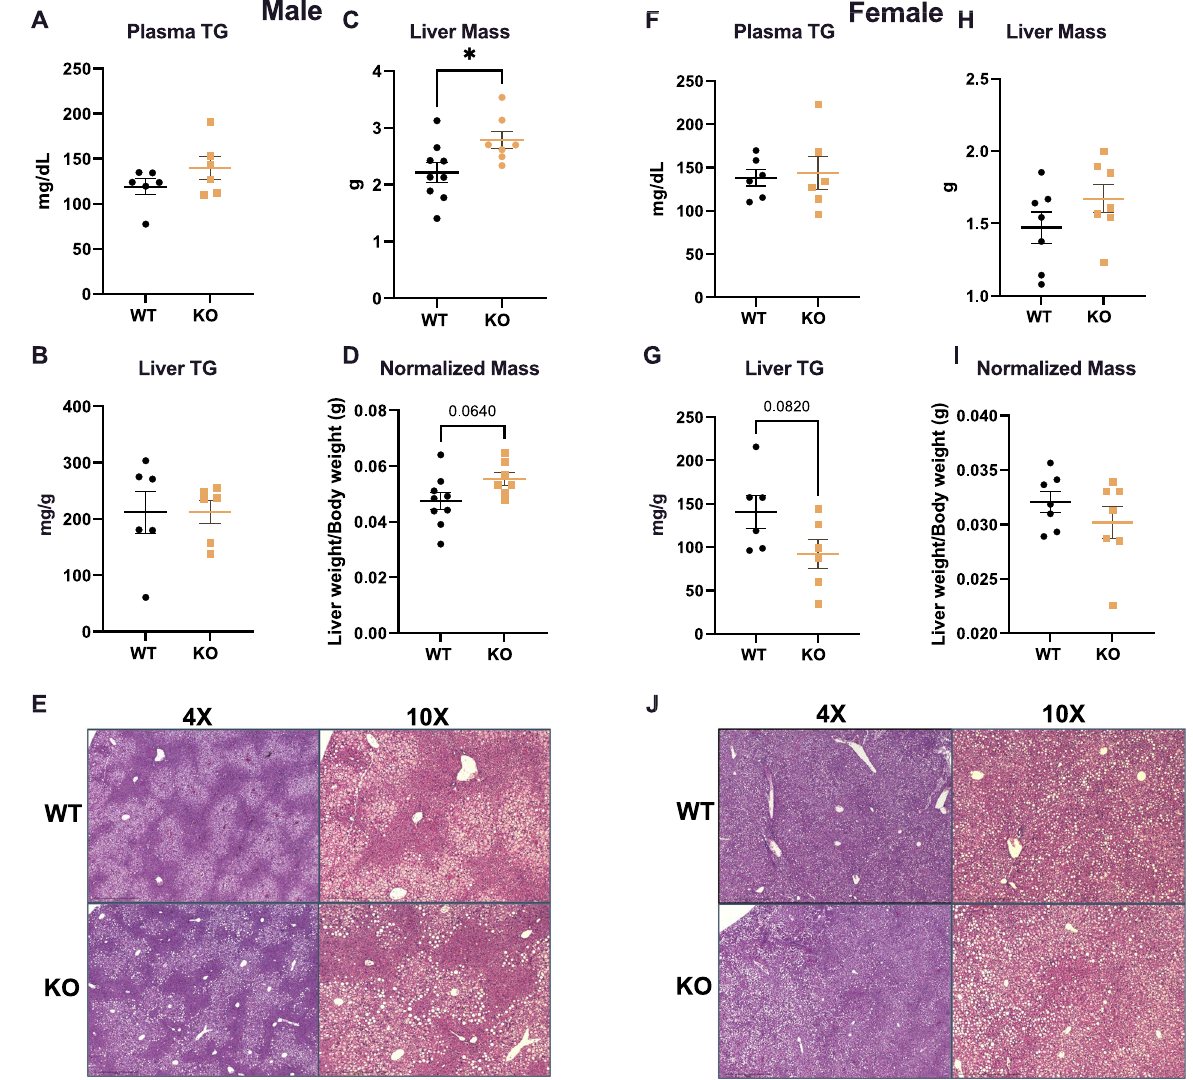
Figure 3. GPR19 deficiency results in increased liver mass in male mice after exposure to a high fat diet. After a 10 week HFD, male and female wildtype or GPR19 KO mice were analyzed for the following parameters: ( A, F ) plasma triglycerides, ( B, G ) liver triglycerides, ( C, H ) absolute liver mass, ( D, I ) liver mass normalized to total body weight, and ( E, J ) histology by H&E stain. Mice were harvested directly after the completion of the IPGTT study, which was initiated after a 6 h morning fast. * P < 0.05, N =